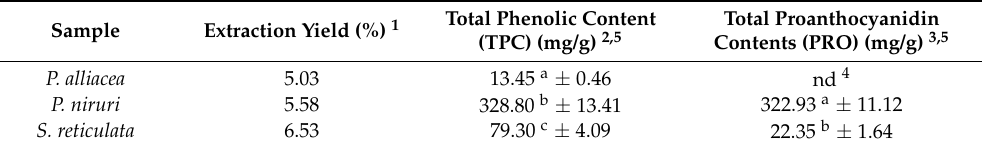
Table 1. Extraction yield and total phenolic content.